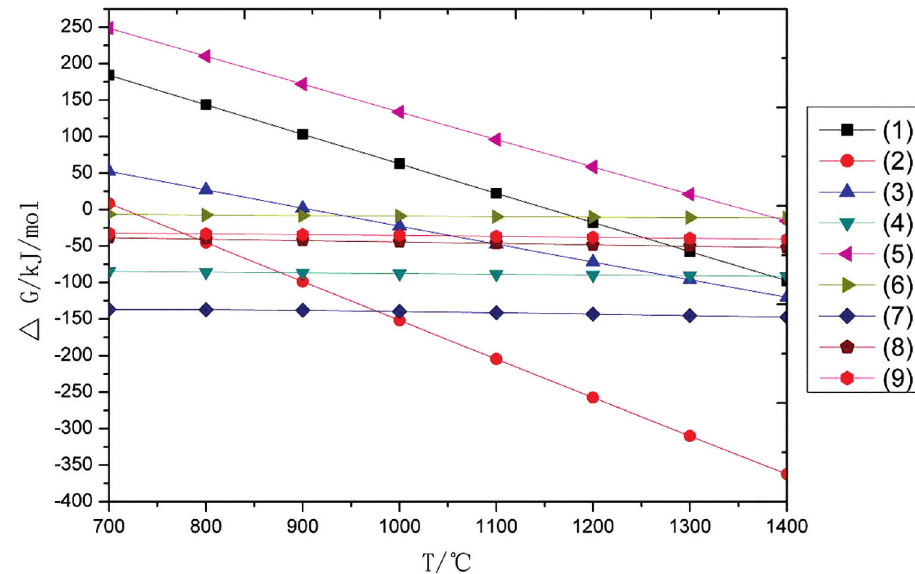
Figure 1: The relationship between Gibbs free energy of each reaction and temperature under vacuum conditions.